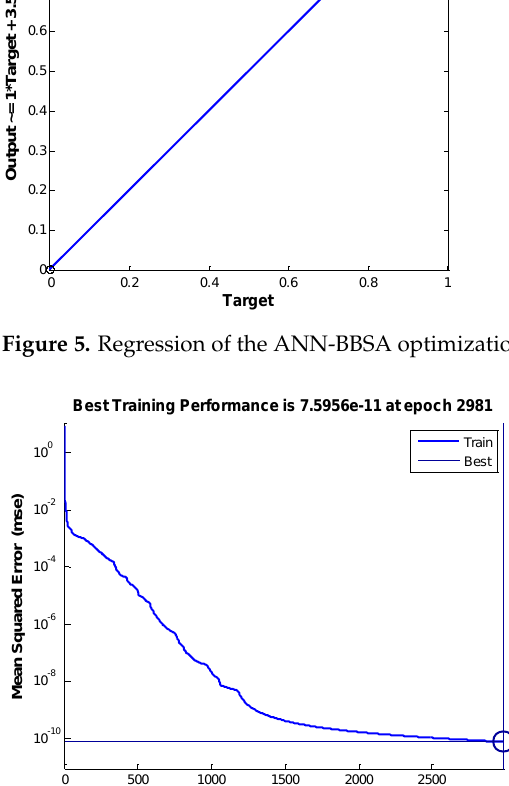
Figure 6. Performance of the ANN-BBSA optimization. It is noted that the value of the regression coefficient represents unity for ANN after 4000 epochs have been applied. The best training performance of the mean square error (MSE) was 7.5956 × 10 −1 1 , which is excellent for the optimal prediction of the ANN-BBSA performance. Overall, the regression coefficient results and performance validate the ac- curacy of the ANN-BBSA. Table 7 shows the active power in MW for all buses in the 14- bus VPP system when using ANN-BBSA. Table 8 shows the total power generated in MW for each MGs when using the ANN-BBSA schedule controller for 24 h. Table 7. Power in MW for all buses in the 14-bus VPP system in the case of using ANN-BBSA.